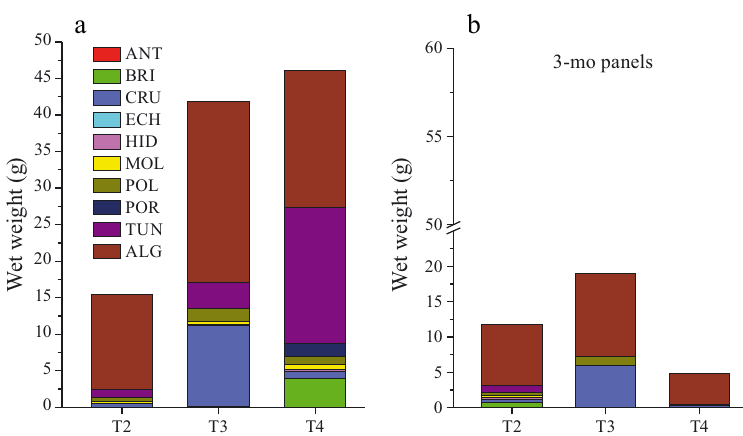
Fig. 3. Mean wet weight and relative composition of biofouling communities on submersed panels. (a) Assemblages recruited on panels left to colonize for 6, 9 and 12 mo (Group A) (collected at T2, T3 and T4, respectively) and (b) panels submersed for 3 mo and collected at T2, T3 and T4 (Group B). ANT: An- thozoa; BRI: Bryozoa; CRU: Crustacea; ECH: Echinodermata; HID: Hydrozoa; MOL: Mollusca; POL: Polychaeta; POR: Porifera; TUN: Tunicata; ALG: